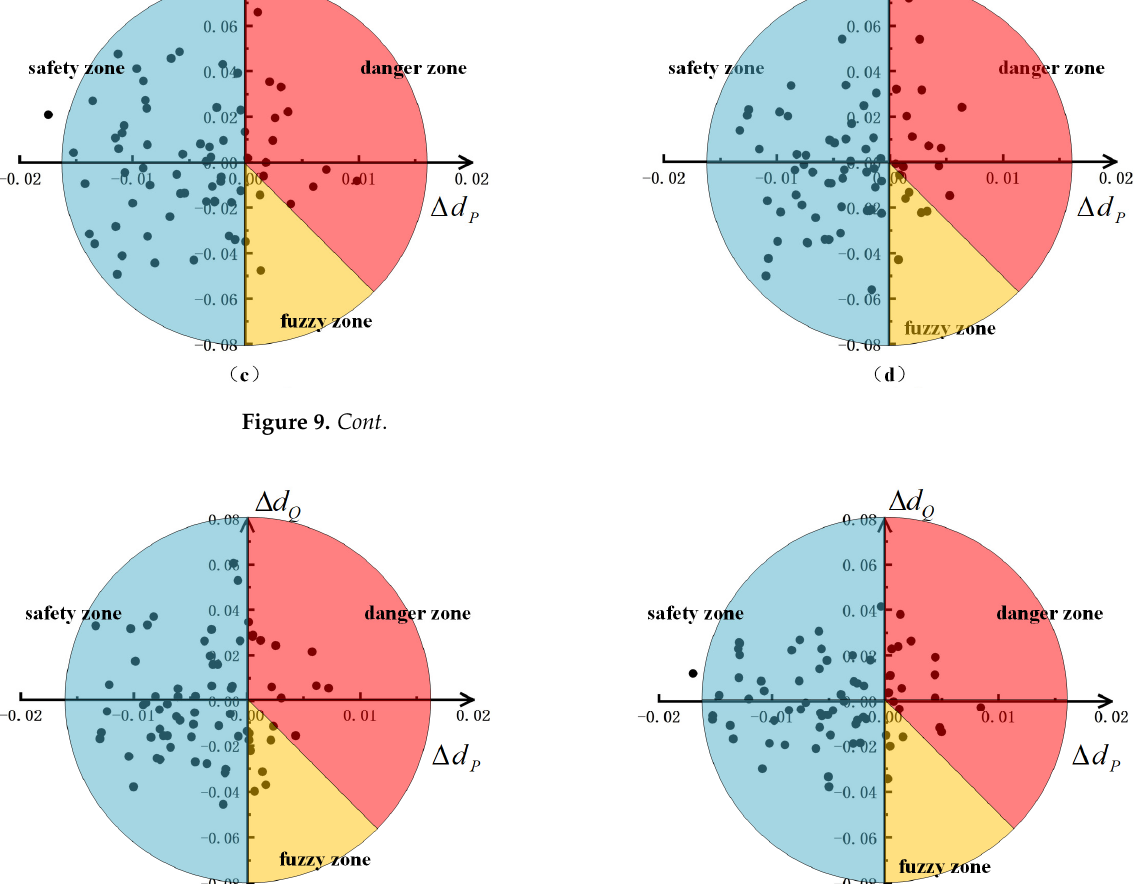
d Δ and d Δ when one impact factor is constant. ( a ) Wind con- Figure 9. Relationship between P Q stant; ( b ) visibility constant; ( c ) channel crossing constant; ( d ) channel width constant; ( e ) ship den- sity constant; ( f ) traffic flow constant.